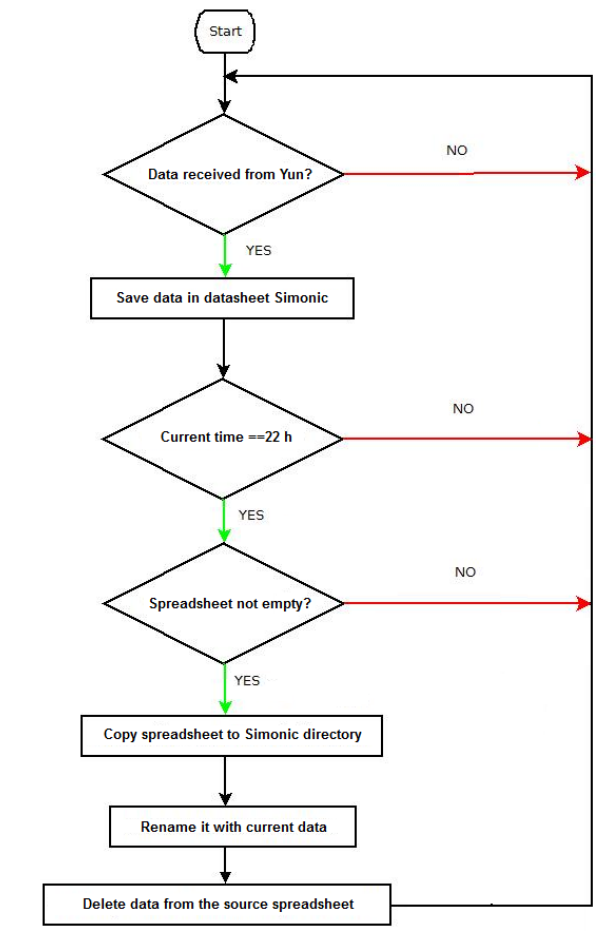
Figure 3: Flowchart for cloud